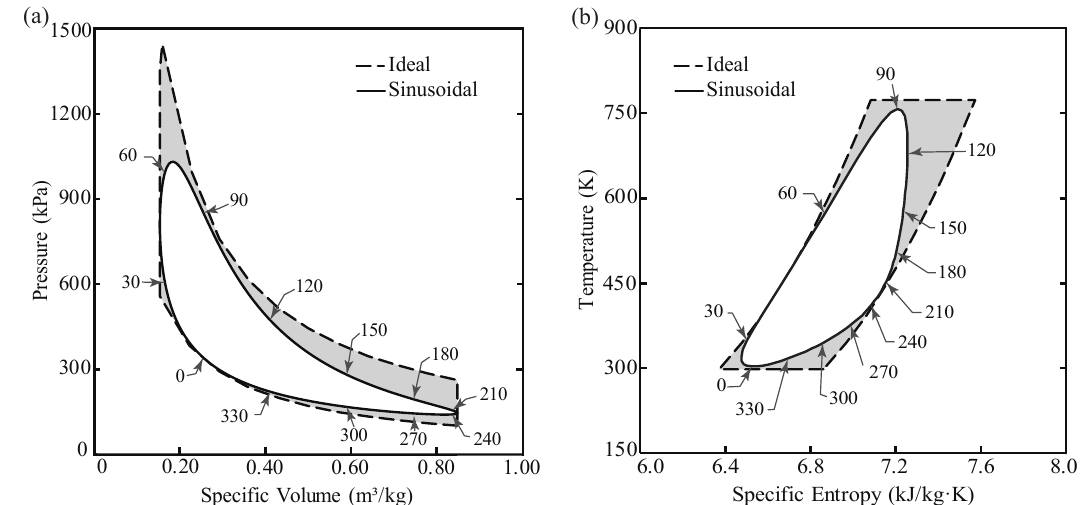
Figure 2. Sinusoidal and ideal cycle plots in ( a ) P - v and ( b ) T - s diagrams for the modeled alpha-type Stirling